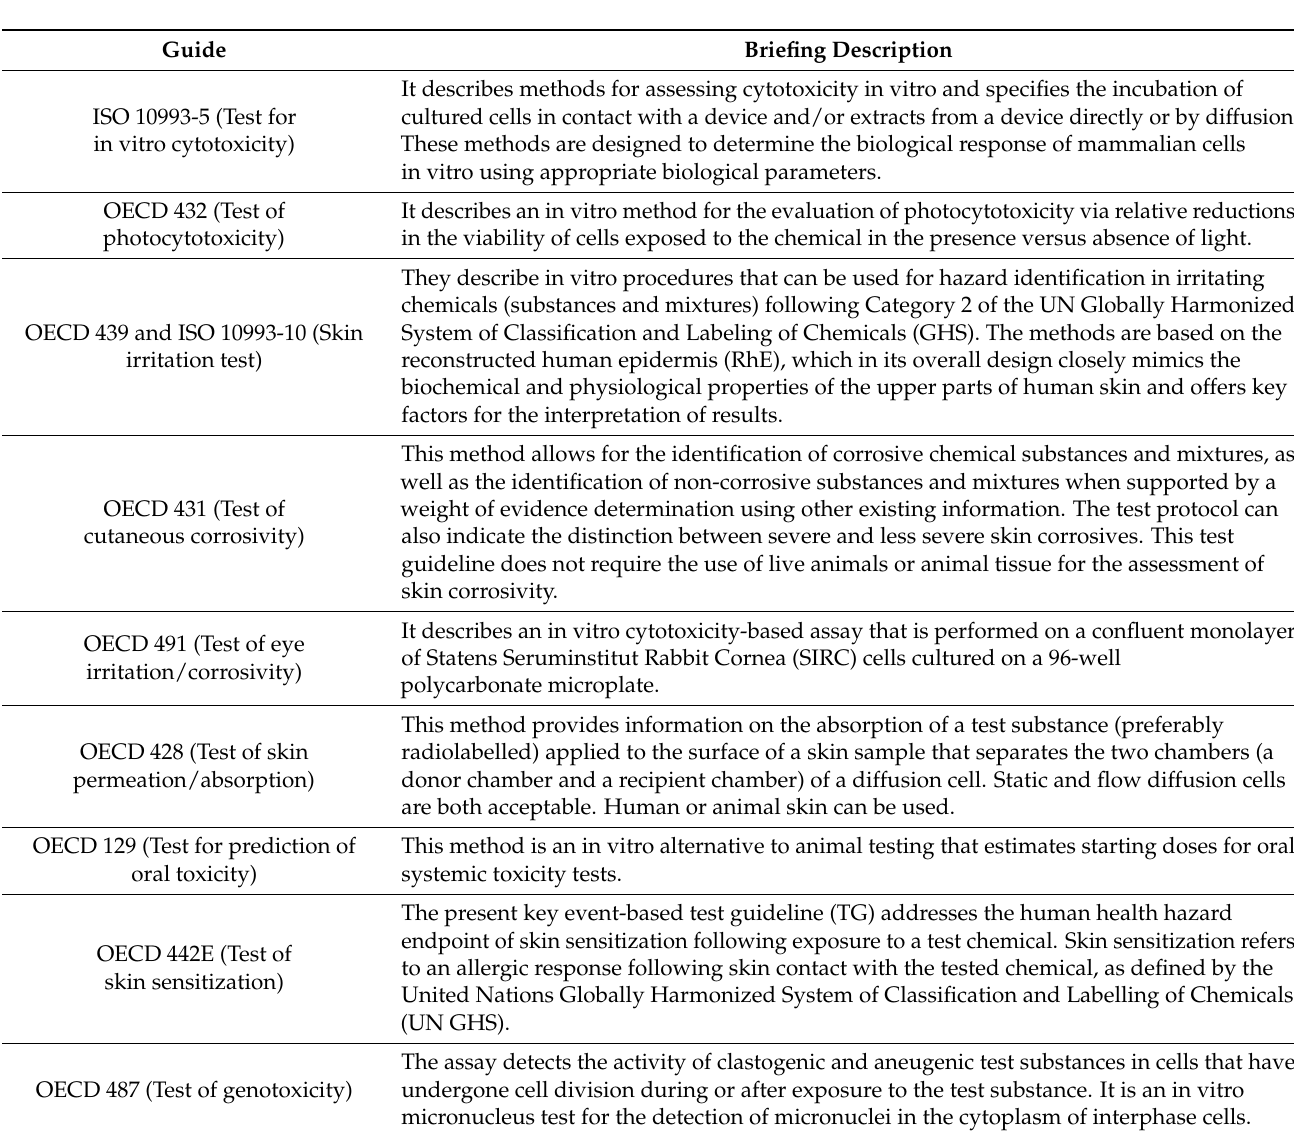
Table 7. Some examples of mandatory tests to be conducted according to the OECD or ISO guidelines for